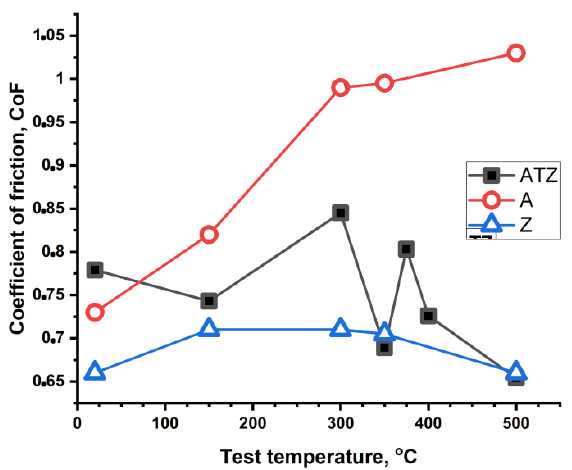
Figure 9. Plots of the coefficient of friction (CoF) values measured at different temperatures of the test. The symbols present the mean value of three single measurements. The standard deviation for each point did not exceed 5% of the measured value.